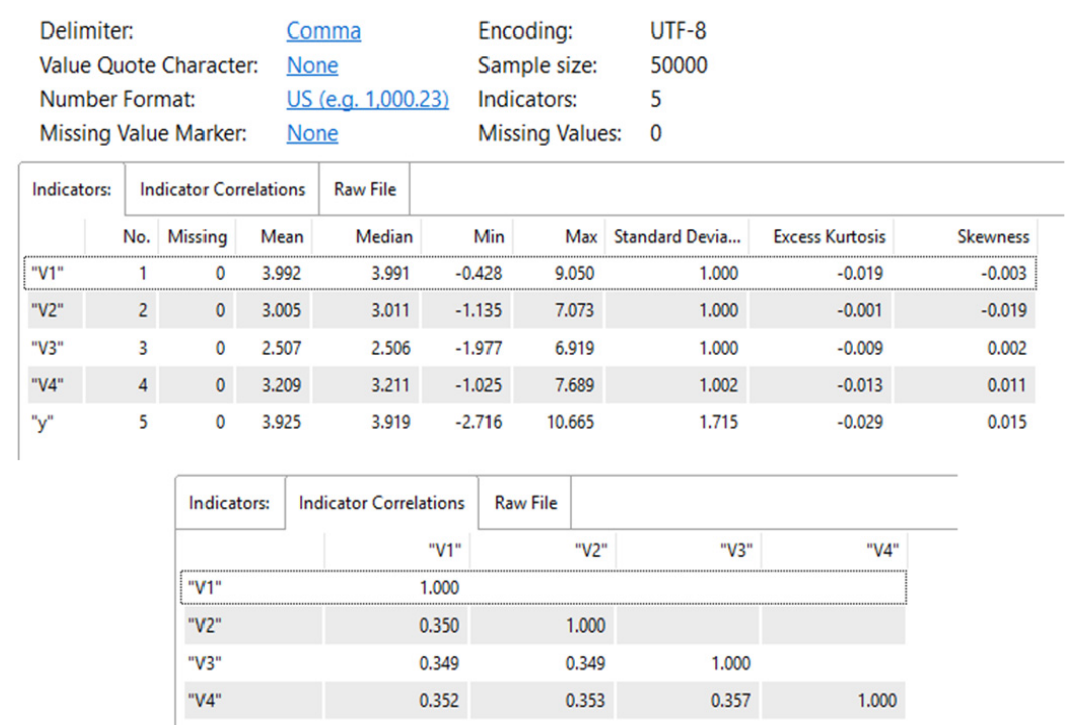
Figure 1. The descriptives of the simulated dataset